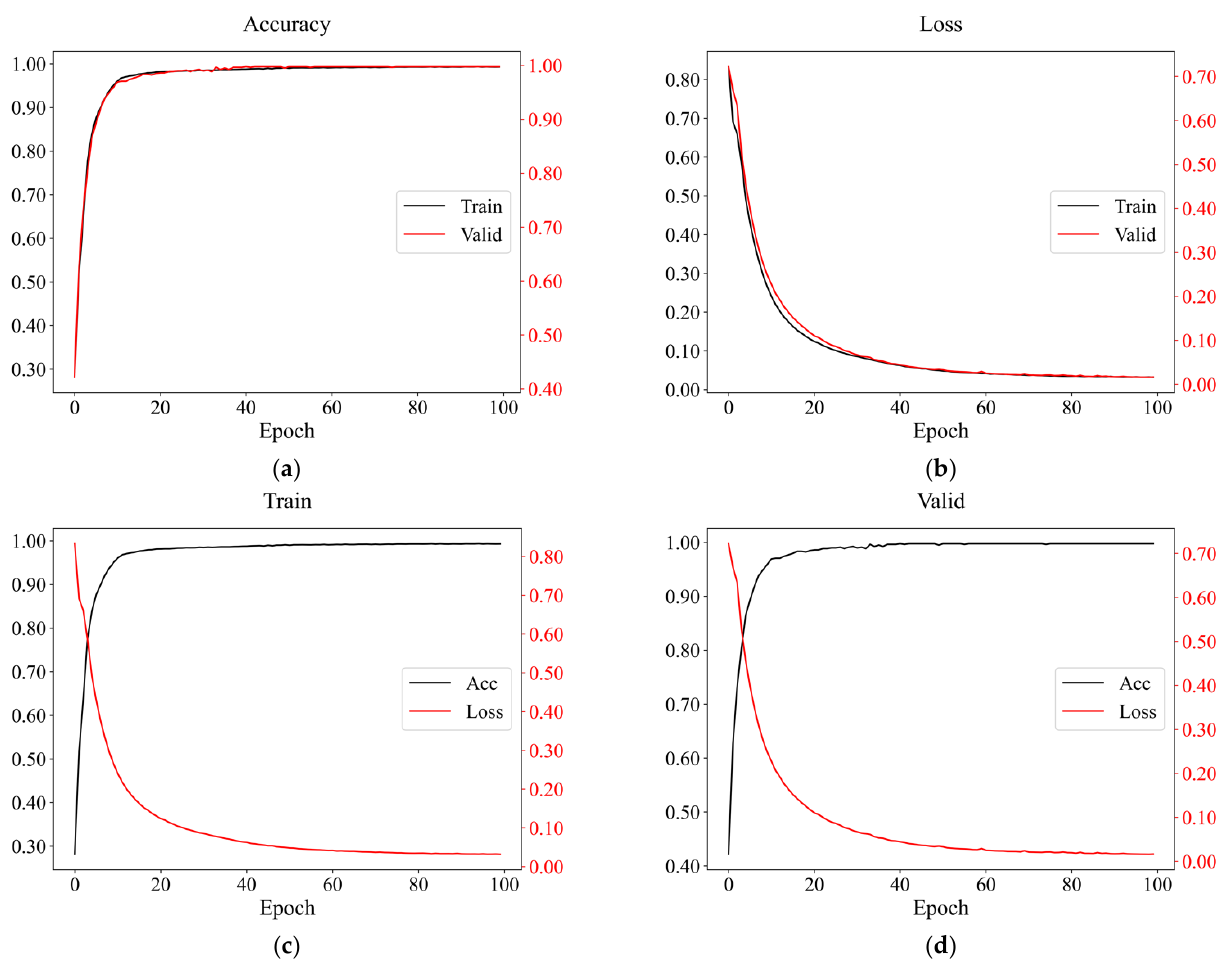
Figure 7. An example of the resulting curves of a four-layer FCNN when K = 7. ( a ) The accuracy and ( b ) the loss curves of the training and validation datasets; the accuracy and loss curves of ( c ) the training and ( d ) the validation datasets. K represents which fold. Table 4. Performances of FCNN models with different hidden layers.